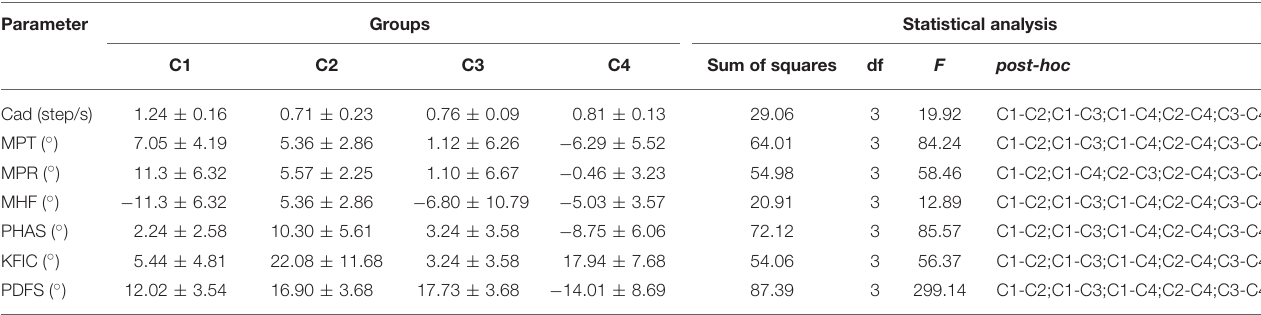
TABLE 5 | Results of the analysis of variance. Parameter Groups Statistical